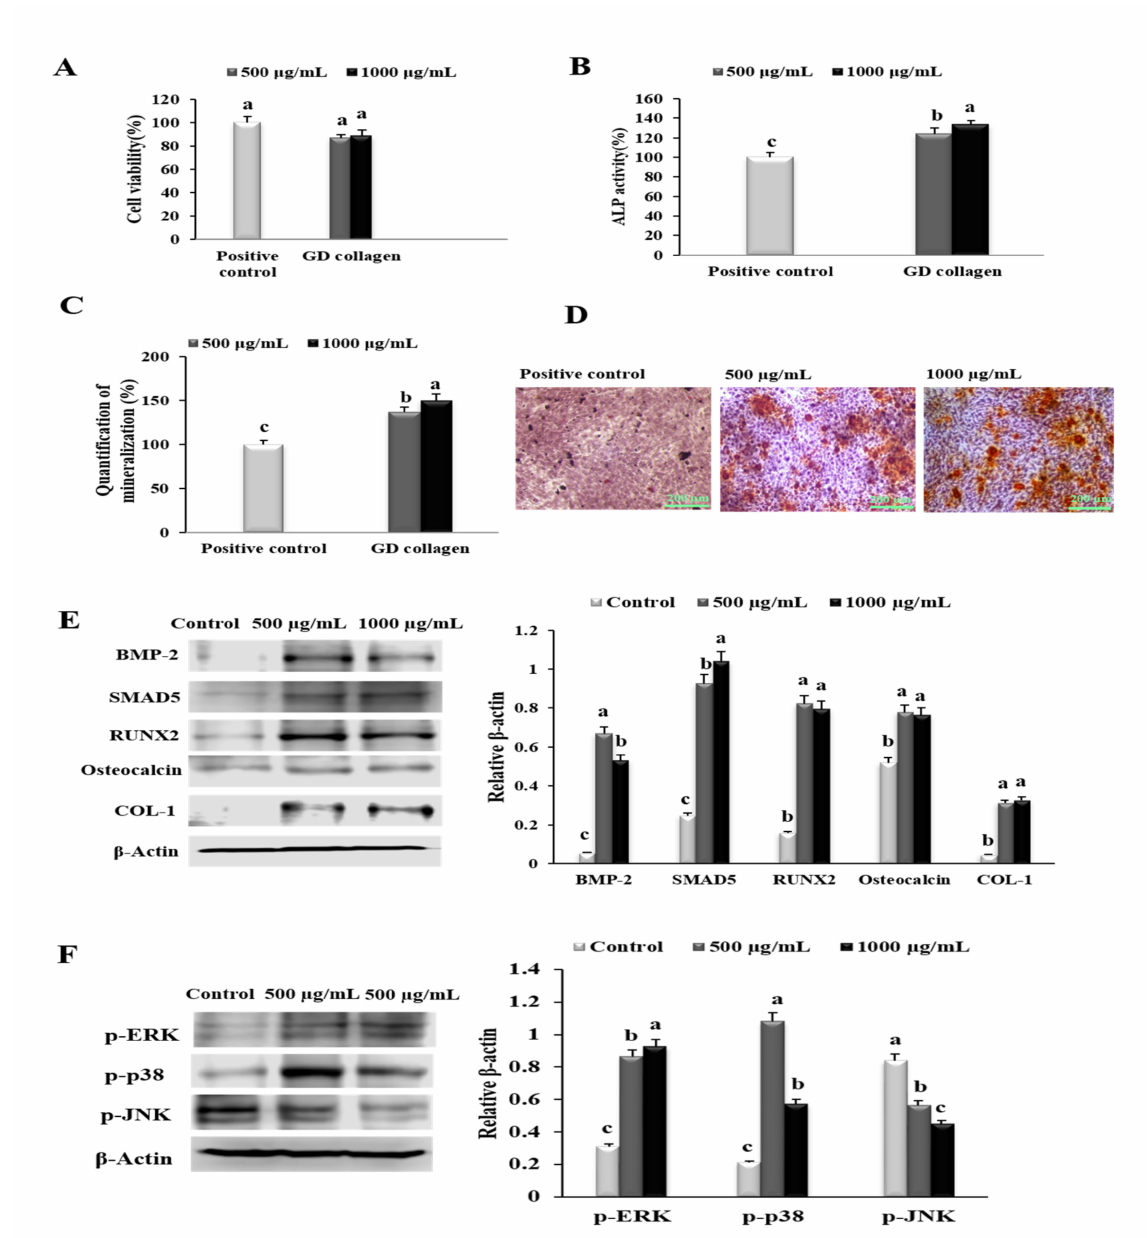
Figure 2. E ff ects of the Yeonsan Ogye chicken breed ( Gallus gallus domesticus) collagen extract, GD collagen, on MG-63 osteoblast cell viability, alkaline phosphatase (ALP) activity, mineralization of osteoblast-secreted bone matrix, protein levels of genes involved in osteoblastic di ff erentiation and bone nodules mineralization, and levels of p-ERK, p-p38, p-AKT, and p-JNK in MG-63 cells. ( A ) MG-63 cell viability. ( B ) ALP activity. ( C ) Quantification of mineralization. ( D ) Staining of the mineralized matrix with alizarin red S. ( E ) Protein expression of bone morphogenetic protein-2 (BMP-2), mothers against decapentaplegic homologue 5 (SMAD5), runt-related transcription factor 2 (RUNX2), osteocalcin, and type 1 collagen (COL-1) were determined by Western blot. ( F ) Levels of phosphorylated extracellular signal-regulated kinase (p-ERK), p-p38, and phosphorylated c-Jun N -terminal kinase (p-JNK) proteins were determined by Western blotting. Expression was quantified using ImageJ and β -actin. Values represent the mean ± standard deviation. Values with di ff erent letters were significantly di ff erent, using Duncan’s multiple range test ( p < 0.05); (scale bar: 200 µ